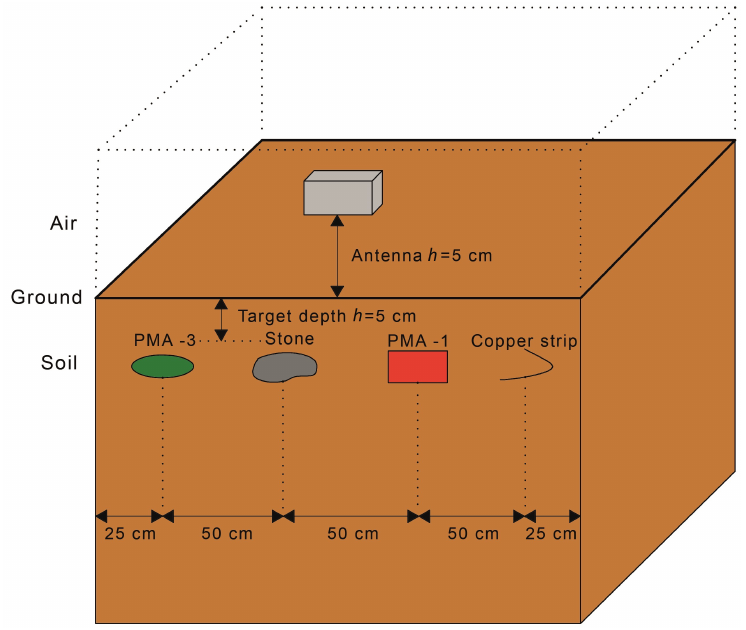
Figure 15. Experimental setup of the real data-I. Table 4. PNSR comparison of data recovery methods for pixel-wise missing case for real data-I. Missing Rate